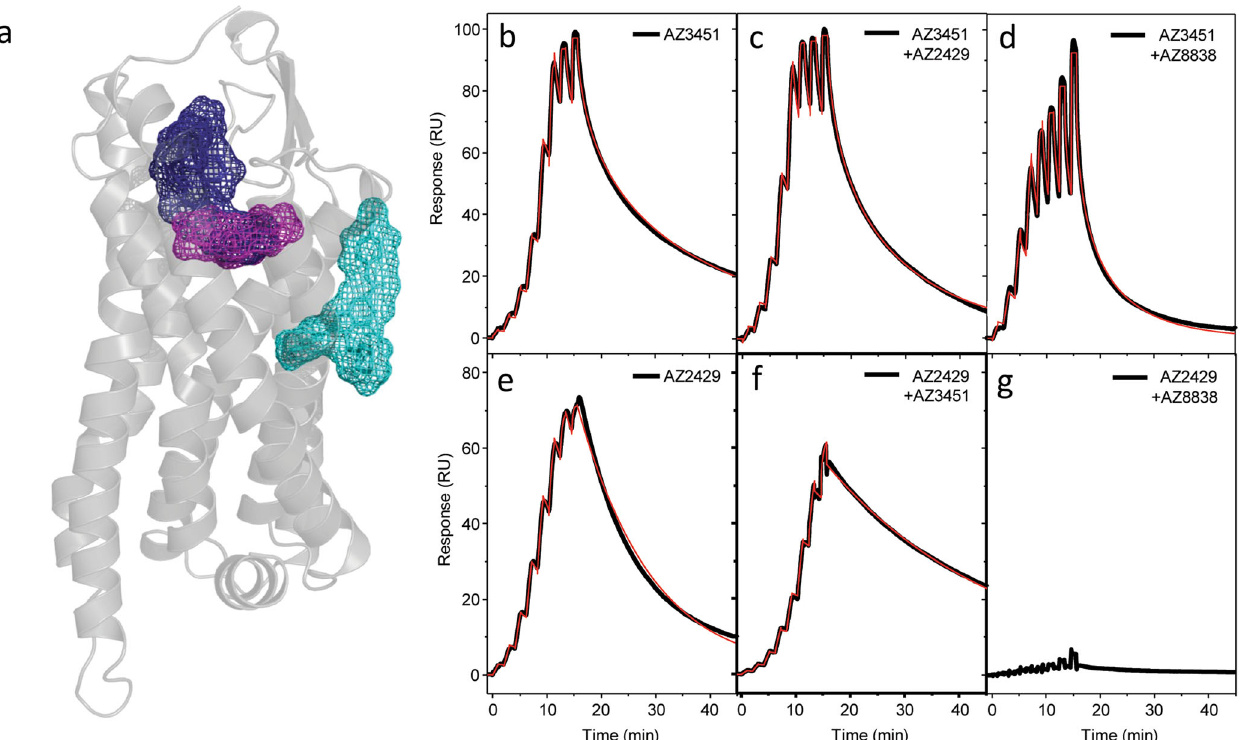
Fig. 3 Interplay between antagonist and agonist binding sites of PAR2 analysed by SPR. a Schematic representation of compound binding sites within PAR2: agonist AZ2429 binding site (blue) shows a partial overlap with the fragment binding site of AZ8838 (magenta), while the AZ3451 binding site (cyan) is on the outside of the helical bundle. Single-cycle kinetic measurements were used to generate the sensorgram pro fi les of AZ3451 binding to b apo-PAR2, c the PAR2-AZ2429 complex and d the PAR2-AZ8838 complex. AZ2429 binding to e apo-PAR2, f the PAR2-AZ3451 complex and g the PAR2-AZ8838 complex was measured in a similar manner. Black curves depict the raw data, whilst the red curves represent the fi tting of the raw data to a 1:1 binding model. The extracted kinetic data are reported in Table 3.